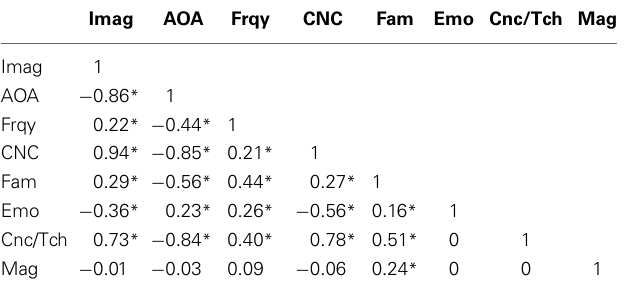
Table 5 | Psycholinguistic and factor score correlation matrix.